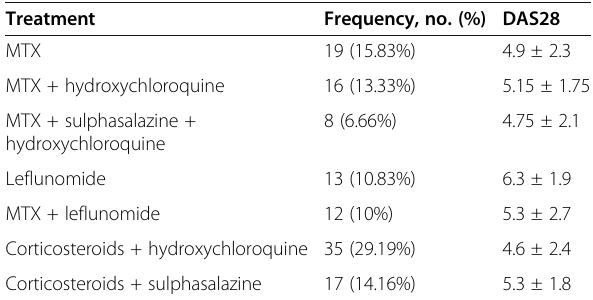
Table 1 Distribution of the patients according to lines of treatment and DAS28 score Treatment